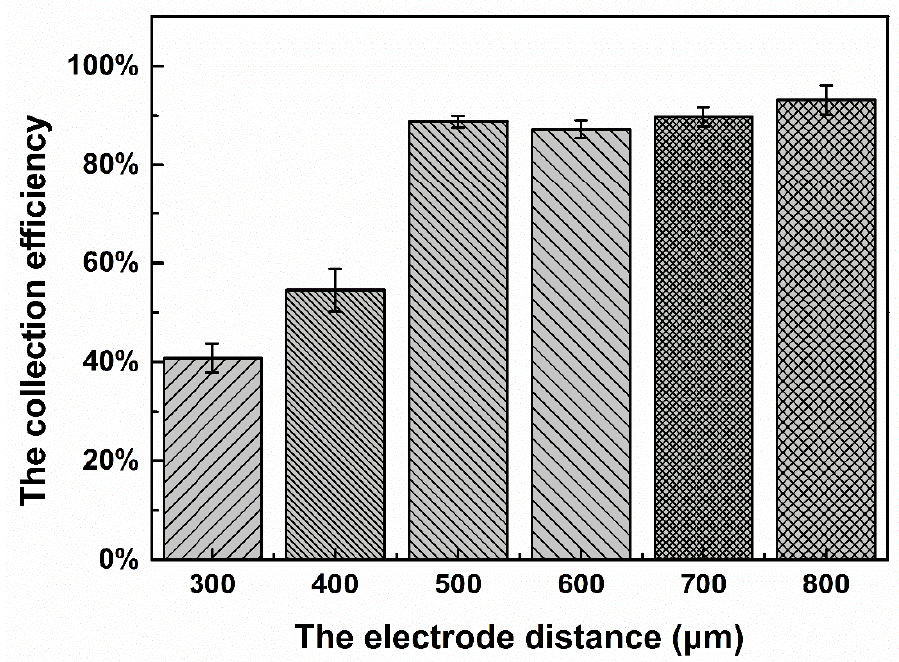
Figure 7. E ff ect of the electrode distance on the collection e ffi ciency of 16.3- µ m Figure 7. Effect of the electrode distance on the collection efficiency of 16.3- μm particles.